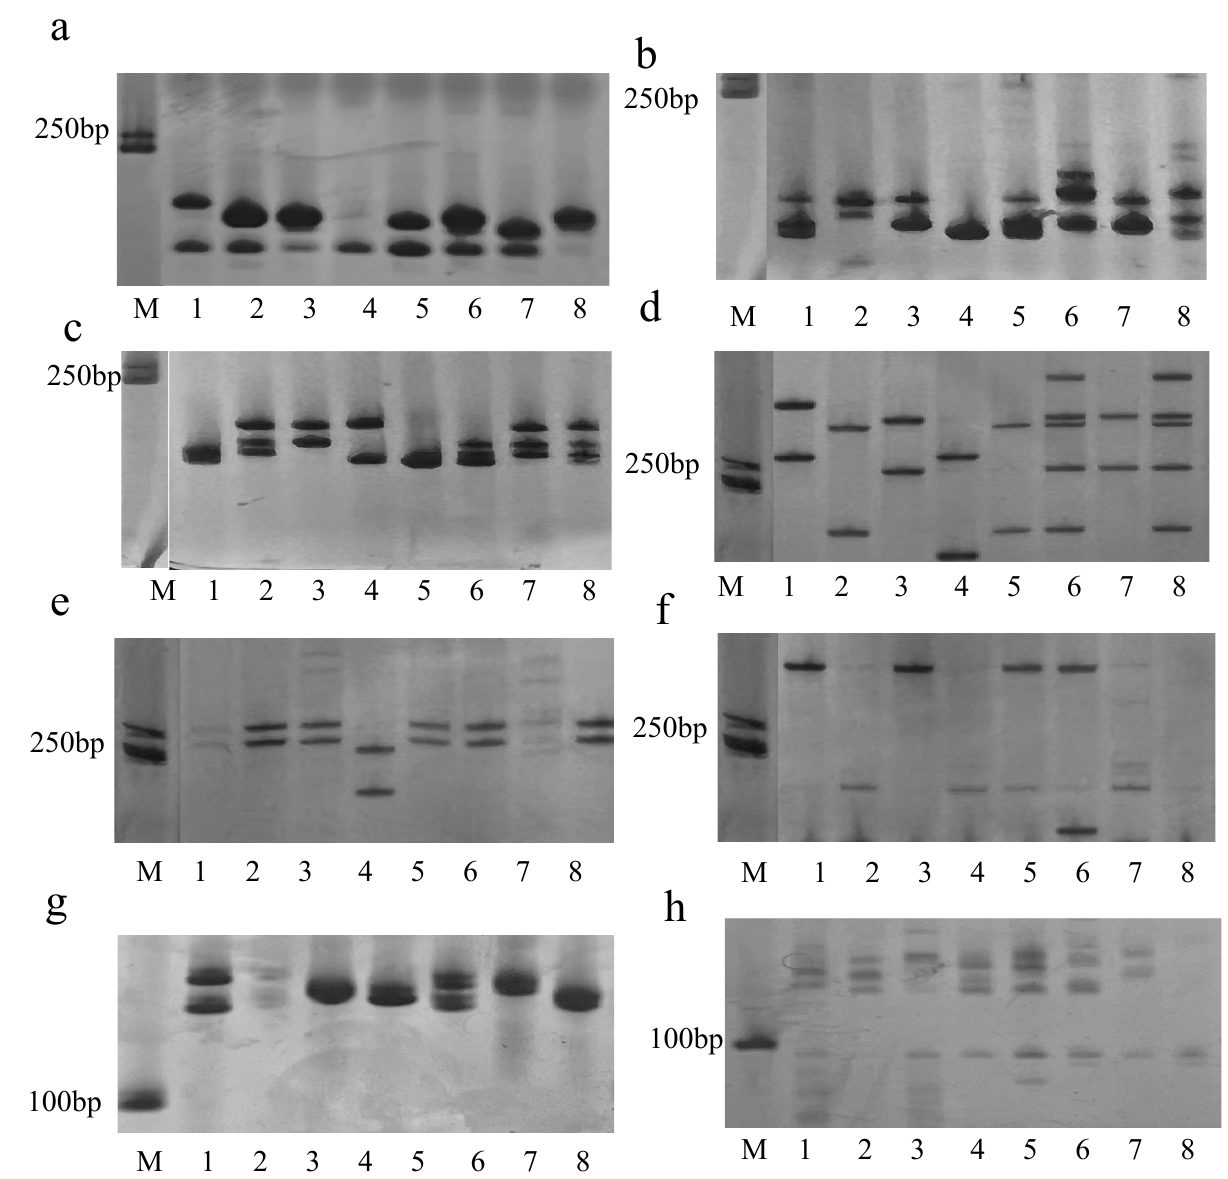
Figure 7. PCR amplification of SSR primers in eight random DNA. M: DNA ladder; sample 1-8. ( a ): 5-14; ( b ): 5-19; ( c ): 5-20; ( d ): 6-2; ( e ): 6-3; ( f ): 6-4; ( g ): 6-6; ( h ): 6-15.